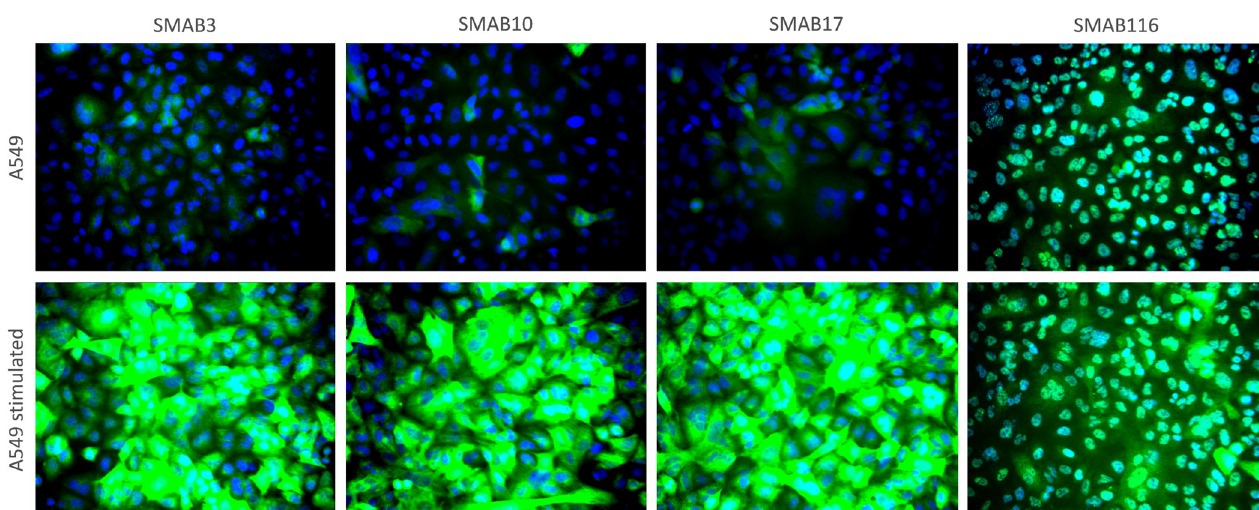
Fig 6. SMABs in immunofluorescence. Immunofluorescence images using 1 ug/ml SMAB to stain fully confluent non-stimulated (top) and BENSpm stimulated A549 cells (bottom). DAPI stained nuclei are shown in blue and the SMAB signal is shown in green.